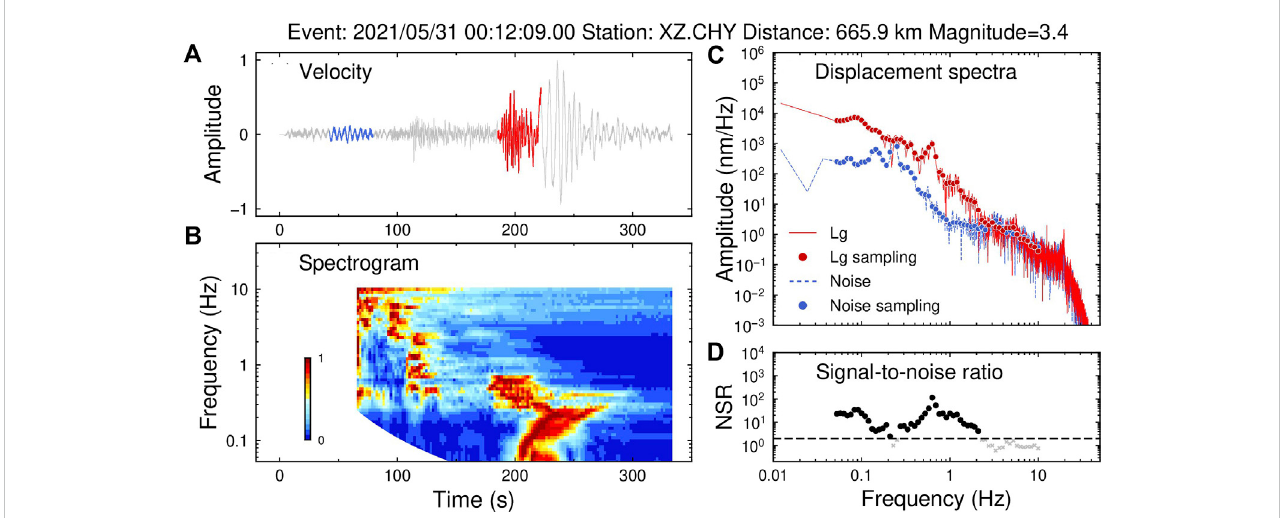
FIGURE 3 (A) Sample seismogram of the Yangbi aftershock recorded at station XZ. CHY. The Lg waveform and pre-event noise are highlighted in red and blue, respectively. (B) Time-frequencyspectrogramofthesampleseismograms. (C) SpectraofLgandpre-eventnoise. (D) Signal-to-noiseratio.TheSNRthreshold of 2.0 is adopted and illustrated by a dashed line. Data points with SNRs lower than 2.0 are discarded and represented by gray crosses.